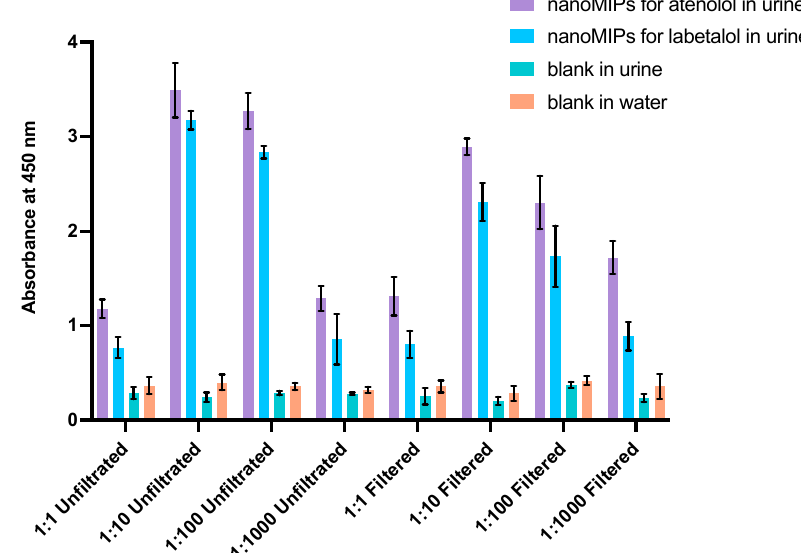
Figure 6. The results obtained in human urine for different dilutions of the HRP-A and HRP-L conjugates and controls. Purple bars represent absorbance corresponding to the binding of the conjugate and nanoMIPs-A, blue to the binding of the conjugate and nanoMIPs-L, and green and orange are controls without